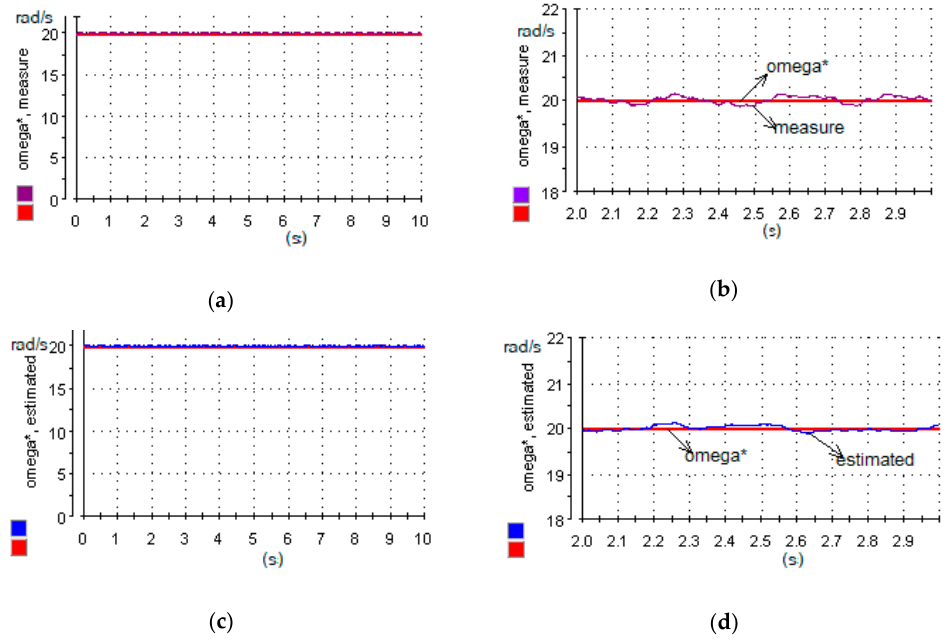
Figure 14. Speed of induction motor with online rotor and stator resistance estimators: ( a , b ) Reference speed and measurement speed; ( c , d ) Reference speed and estimated speed.